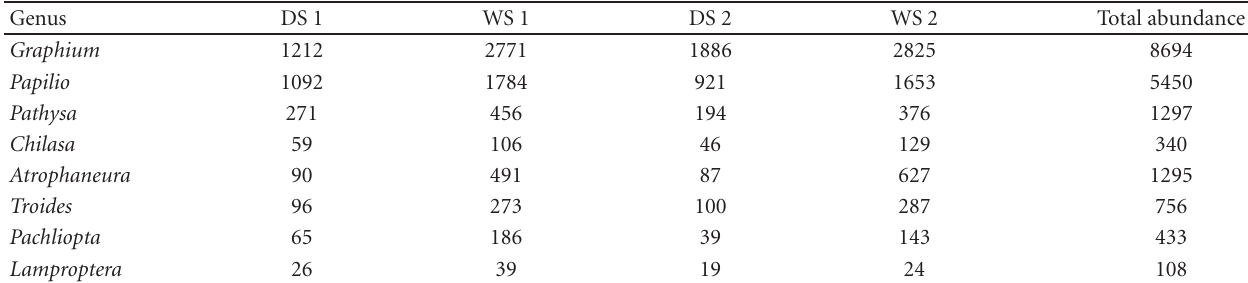
Table 2: Total number of individuals of Papilionid (per genus) sampled during the dry and wet seasons of 2003-2004 within the study